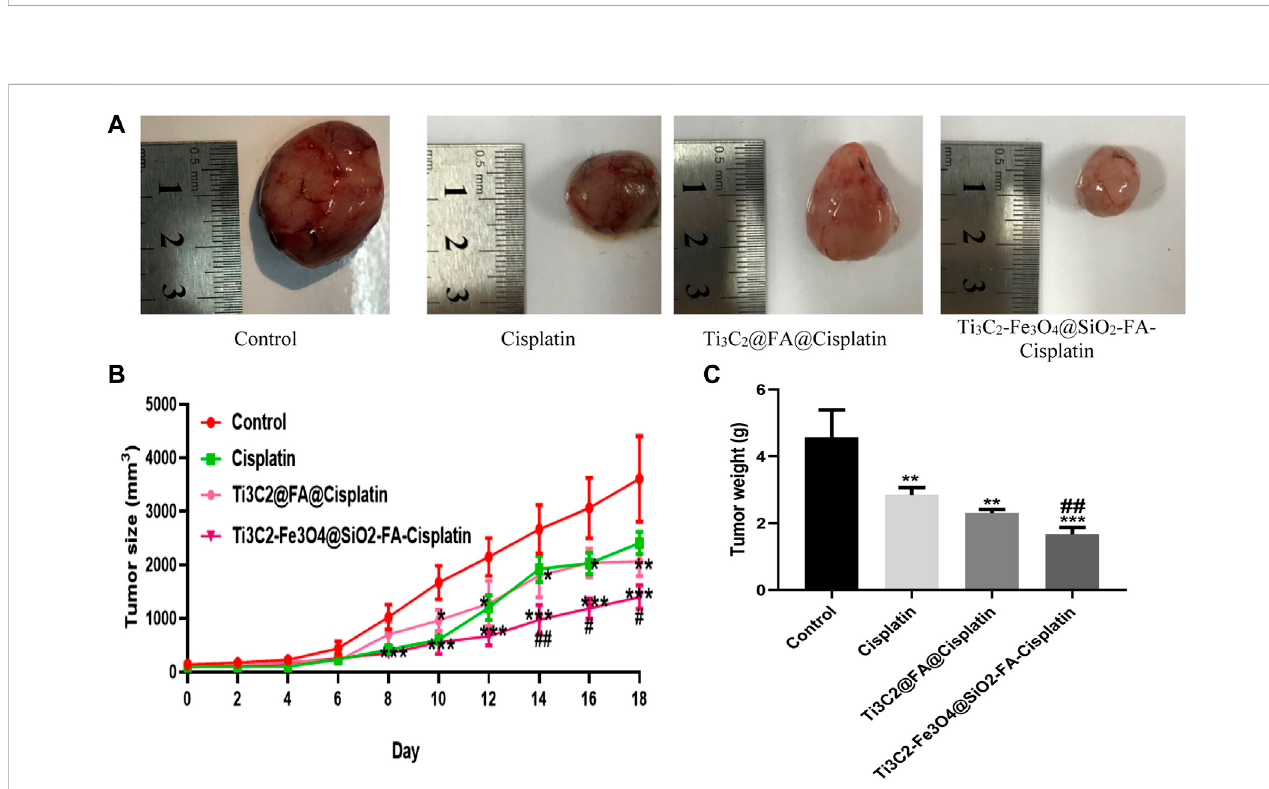
FIGURE 9 (A) Ti3C2-Fe3O4@SiO2-FA-Cisplatin reduces tumor size and weight in cervical cancer tumors. Effect of Ti 3 C 2 -Fe 3 O 4 @SiO 2 -FA-Cisplatin, Ti 3 C 2 @ Cisplatin, and Cisplatin on tumor size (B) during experiment and tumor weight (C) in a cancerous mouse model of cervical cancer at the last of